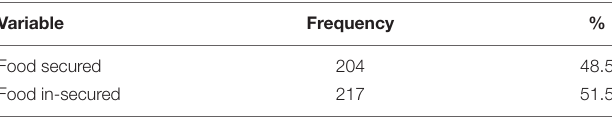
TABLE 5 | Household food insecurity access-related conditions, Dessie Town, South Wollo Zone, Northeastern Ethiopia, 2021. Variable